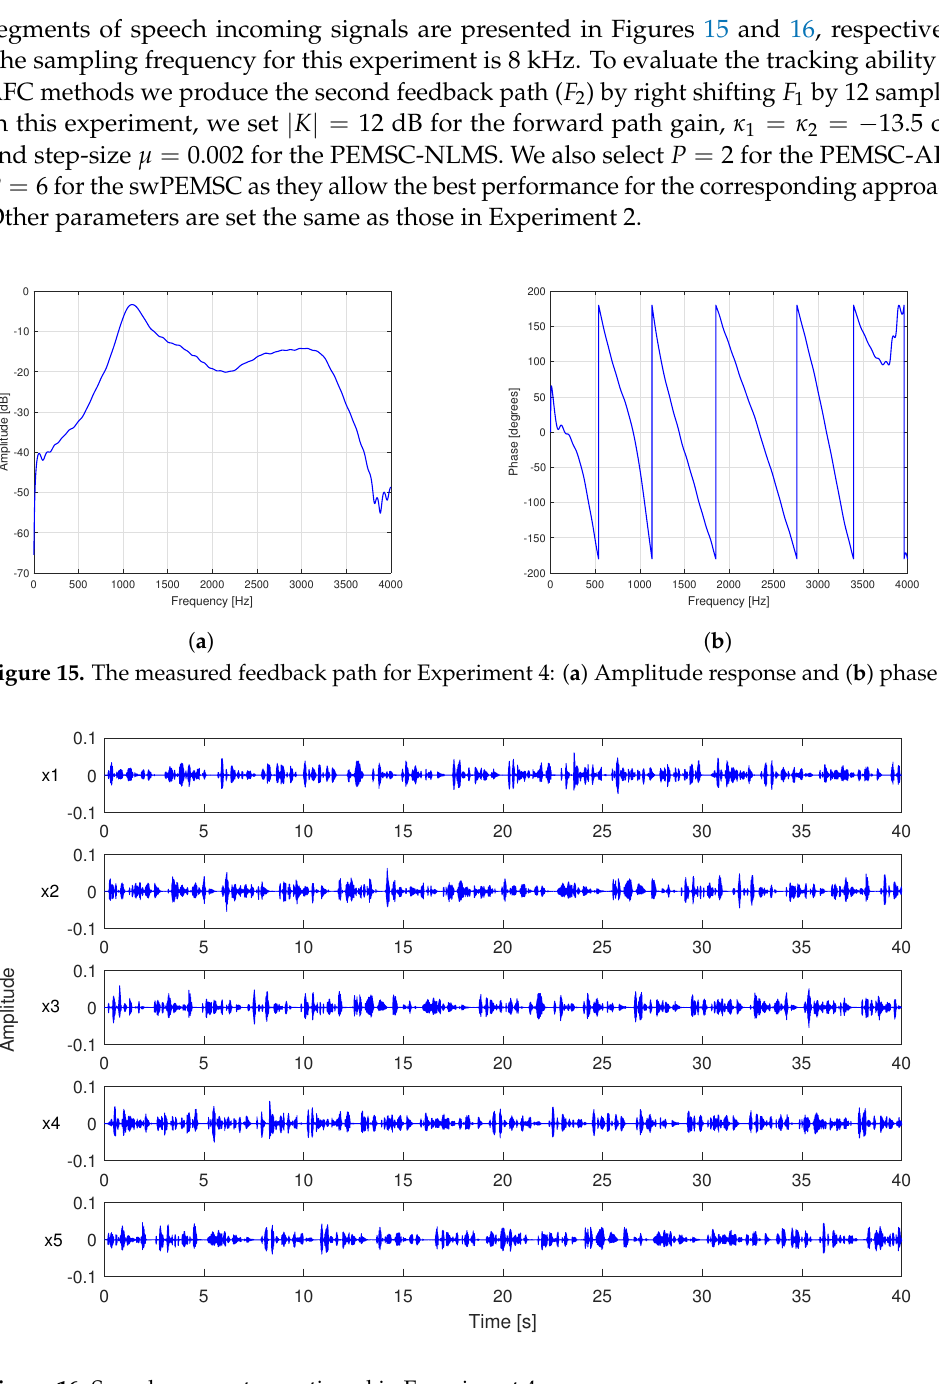
Figure 16. Speech segments mentioned in Experiment